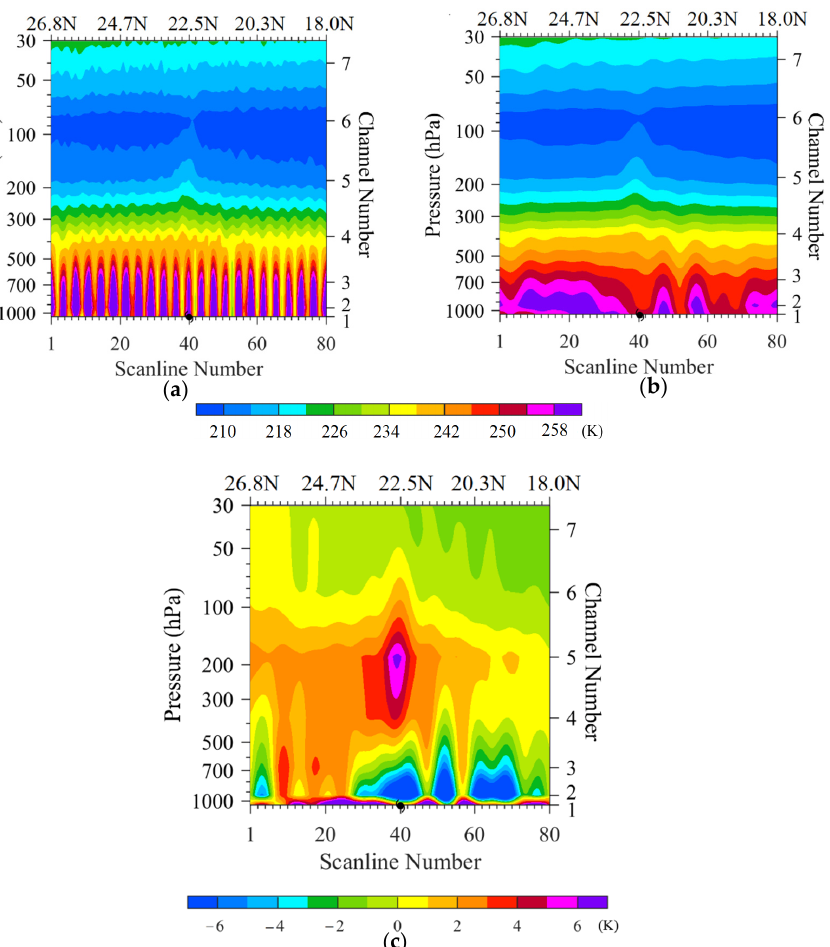
Figure 13. ( a ) Along-track cross-sections of TB observations at channels 1–7 at the 5th FOV (indicated in the first panel in Figure 5) passing through typhoon Lekima’s center position at 2157 UTC 7 August 2019. ( b ) Same as ( a ) except for having removed the data noise. ( c ) Same as ( b ) except for having subtracted the TB observations at the 80th